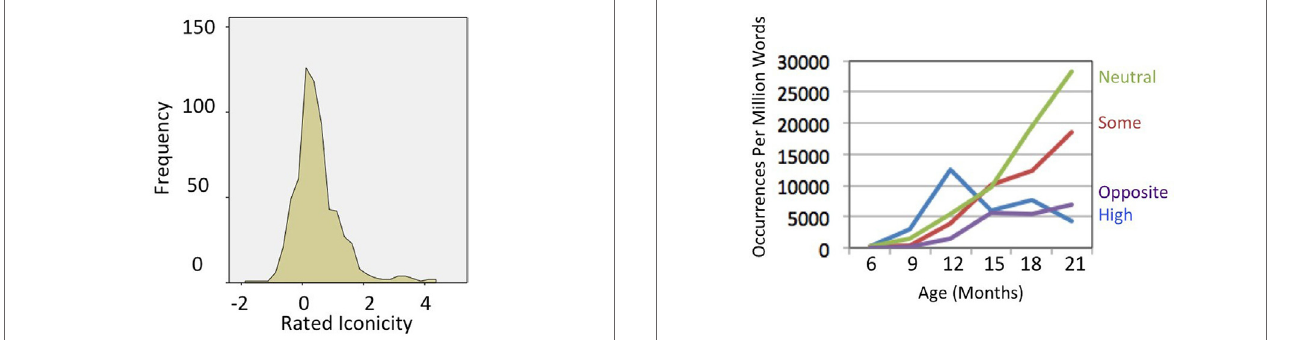
FigUre 1 | Distribution of iconicity ratings for the 644 words from the Macarthur-Bates communicative Development inventories used in the iconicity ratings and the analyses in experiment 1 .